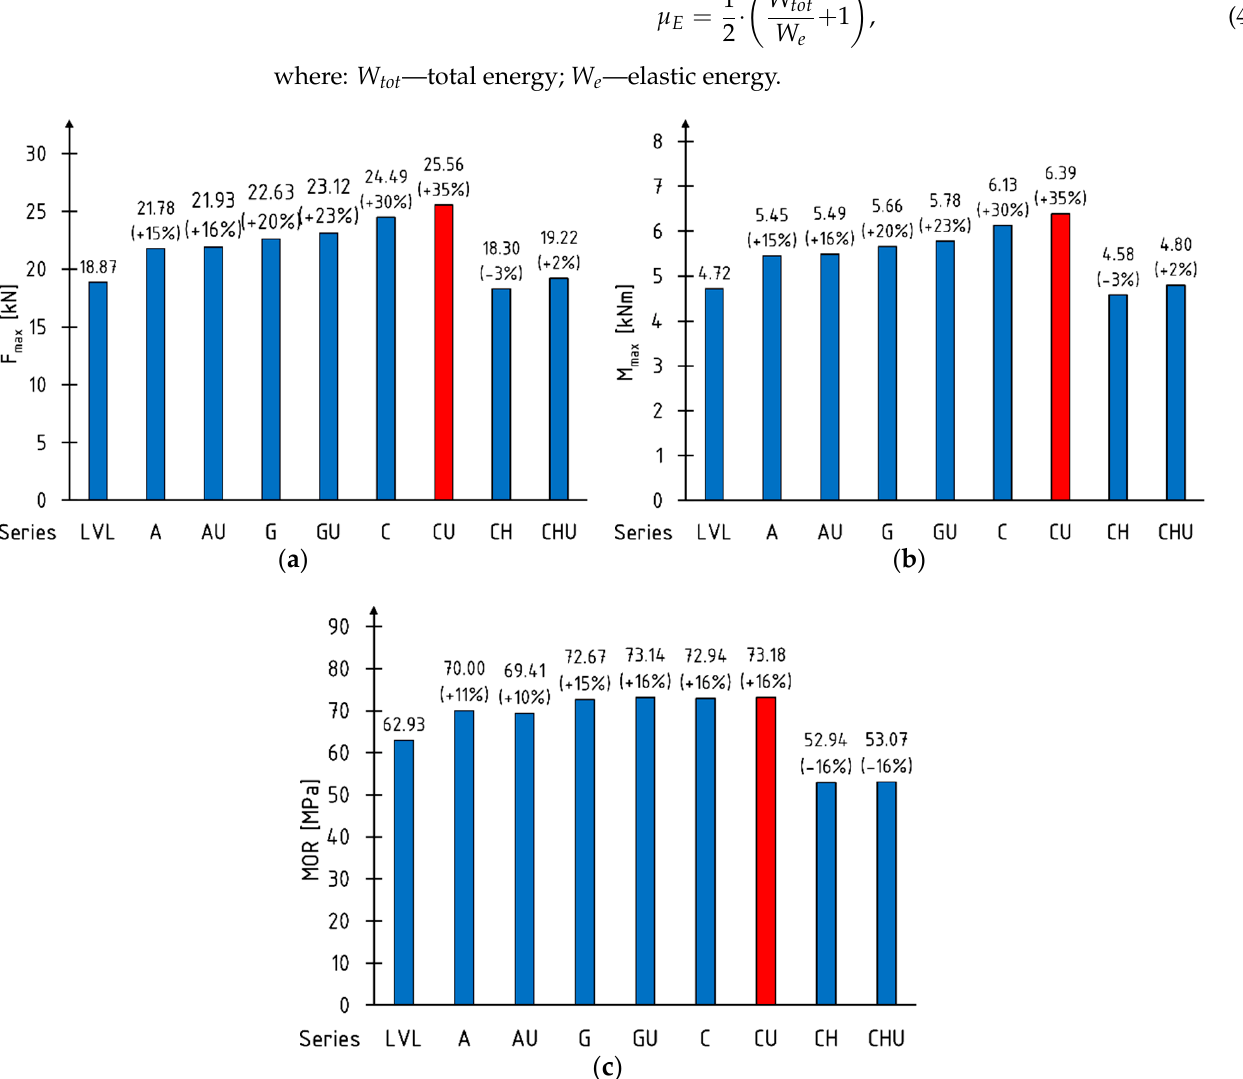
Figure 6. Force versus deflection curves for selected beams. 3.2. Ductility Ductility is defined as the ability to withstand plastic deformation while maintaining the required level of load bearing capacity until failure. Element deformation can be con- sidered in terms of deflection, curvature or strain [62,63]. Based on this definition, ductility can be expressed in terms of deformation measures (dimensionless deformation rates) or energy absorption (dimensionless energy rates). In the case of beams reinforced with steel bars, for which plastic deformations can be unequivocally determined, the ductility can be determined as the ratio of the limit value of the deformation to the value at the yield point. For the elements reinforced with FRP materials, determining the yield point may be difficult or even impossible. The ductility analysis was carried out with the use of three indicators, hereinafter referred to as D , µ Δ , and µ E . The simplest measure of ductility, marked with the symbol D , of a timber beam rein- forced with FRP material, is based on a comparison of the unreinforced element deflection value with the reinforced element deflection, according to the following formula [22]: D = u Fmax,w u Fmax,nw ,